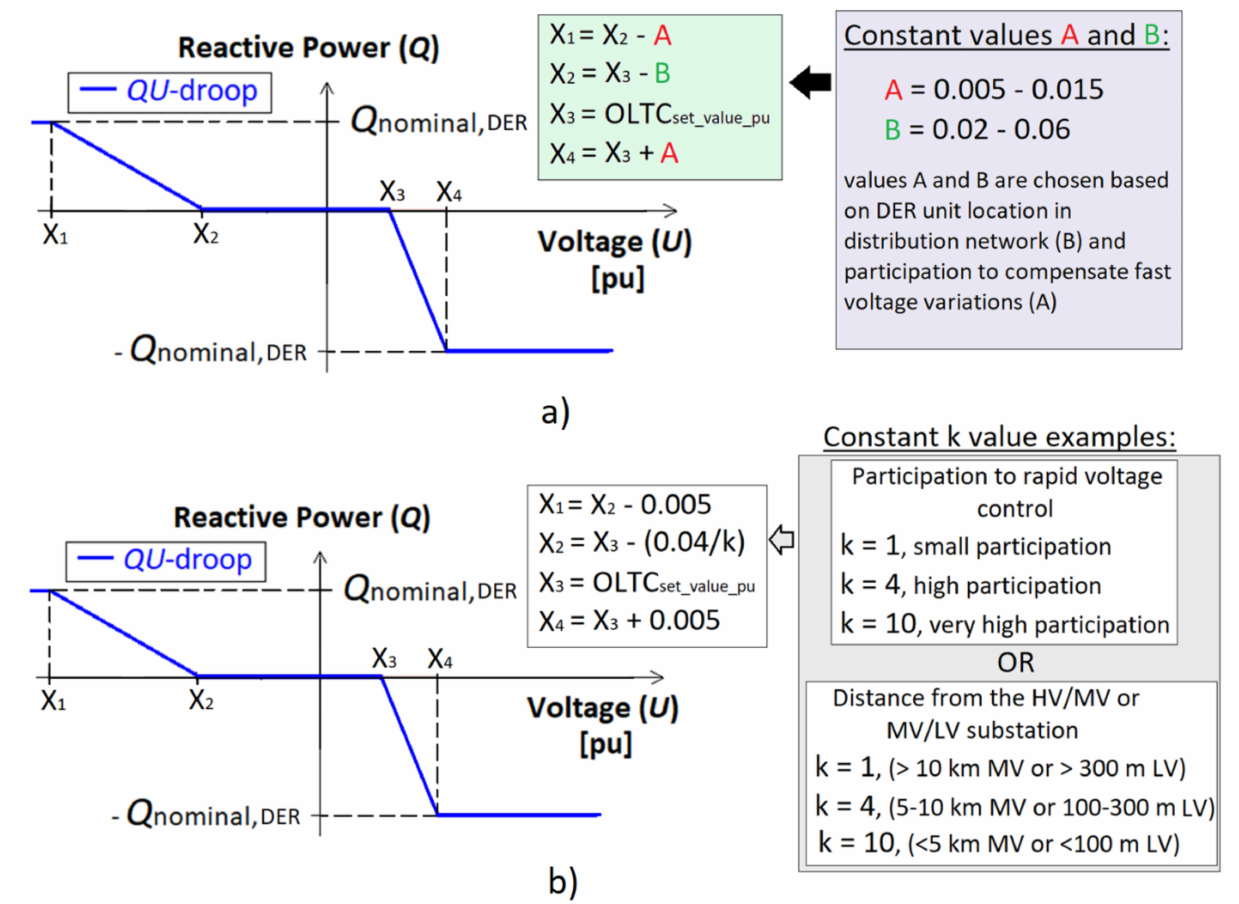
Figure 4. Real-time adaptive DER unit QU -droop-based on OLTC set value, OLTC setting value, location, and participation to rapid voltage control with ( a ) constants A and B [81] or ( b ) constant k (see Tables 3 and